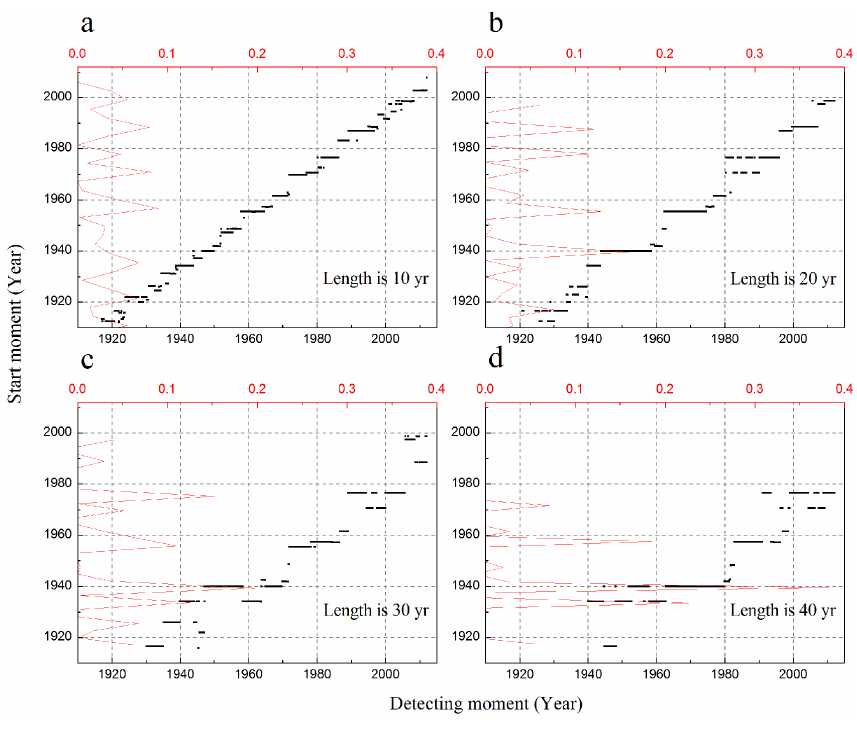
Figure 7. Start moment of the abrupt change in PDO index series with different detecting moments. The x axis refers to the detecting moment of each sub-sequence detected, or the moment for detecting the time sequence, while the y axis refers to the start moment. The black short line indicates the start moment of the abrupt change, which is detectable in a rather long time period; and the red line refers to the frequency of the start moment. (a–d) are the different conditions in which the lengths of sub-sequence are set as 10a, 20a, 30a, and 40a.